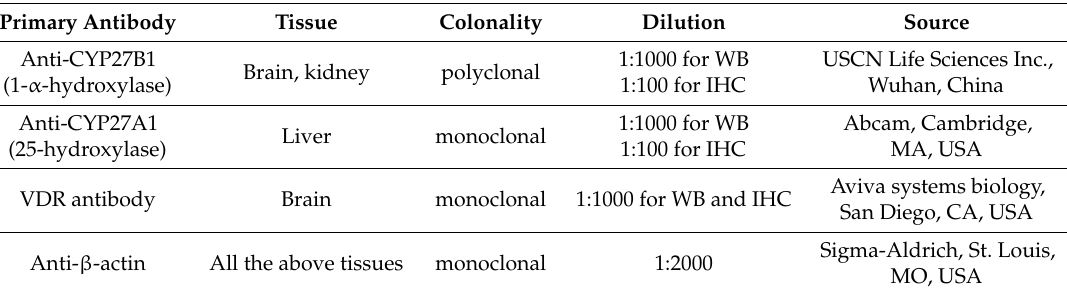
Table 1. List of Primary